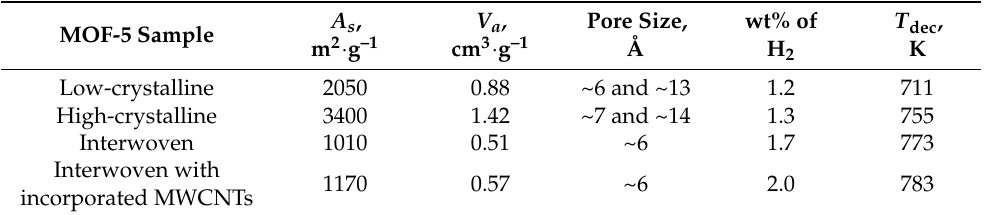
Table 1. Specific surface area, pore volume, and H 2 adsorption for structurally modified